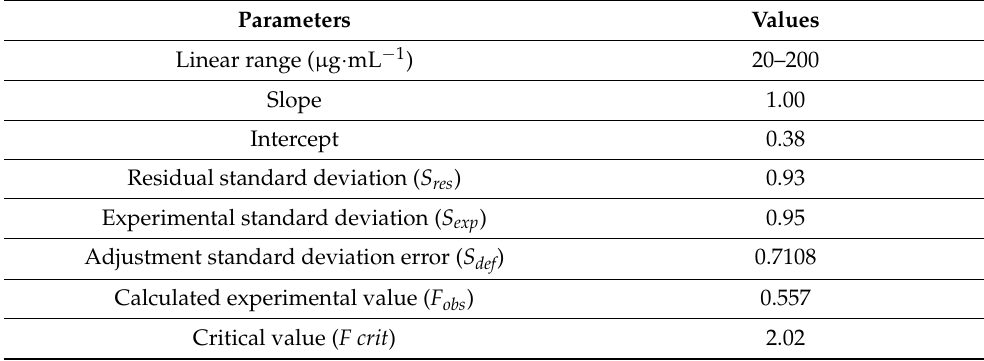
Table 2. Linear regression parameters of PPD in standard solution.